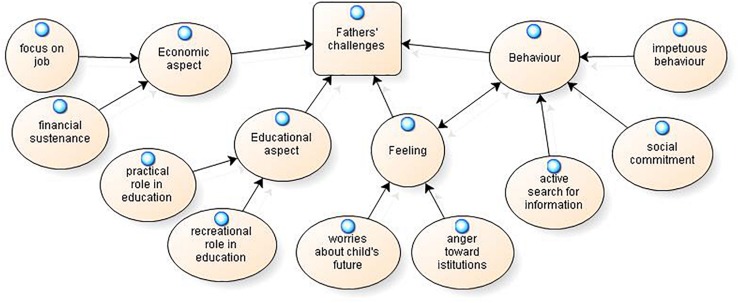
Fathers’ challenges.